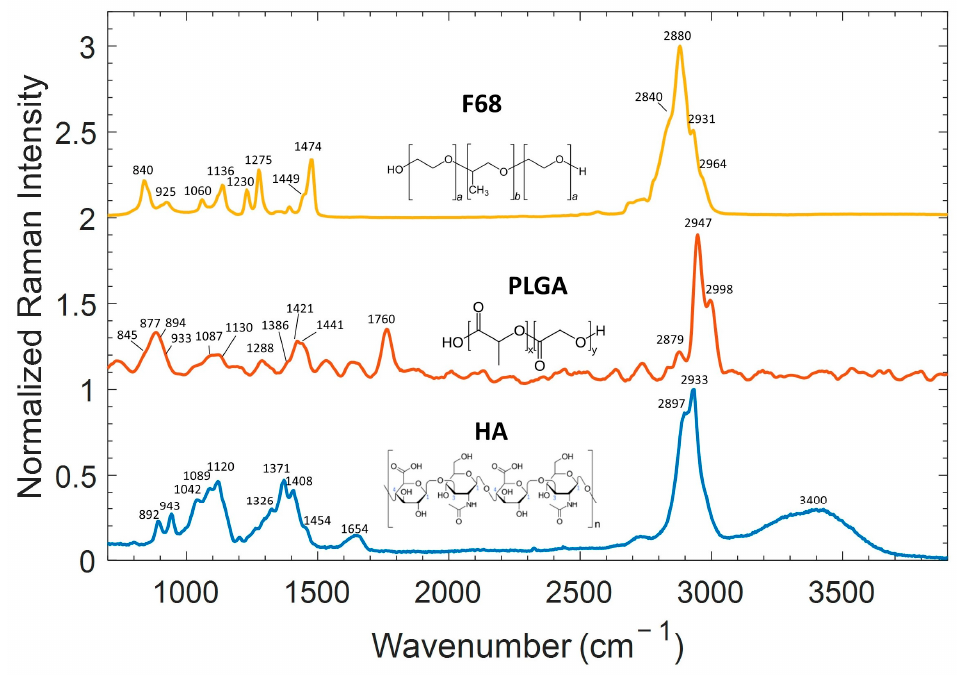
Figure 1. Comparison of Raman spectra of (yellow) F68 (a = 76, b = 29), (red) PLGA (x = 50, y = 50), and (blue) HA powders acquired with an integration time of 50 s and a Raman probe of 15 mW. For a better comparison, spectra were normalized and shifted.